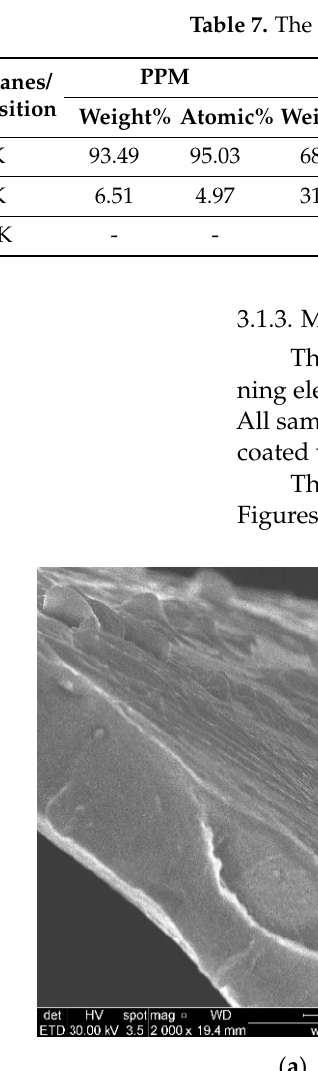
Table 7. The surface composition of the prepared impregnated membranes.